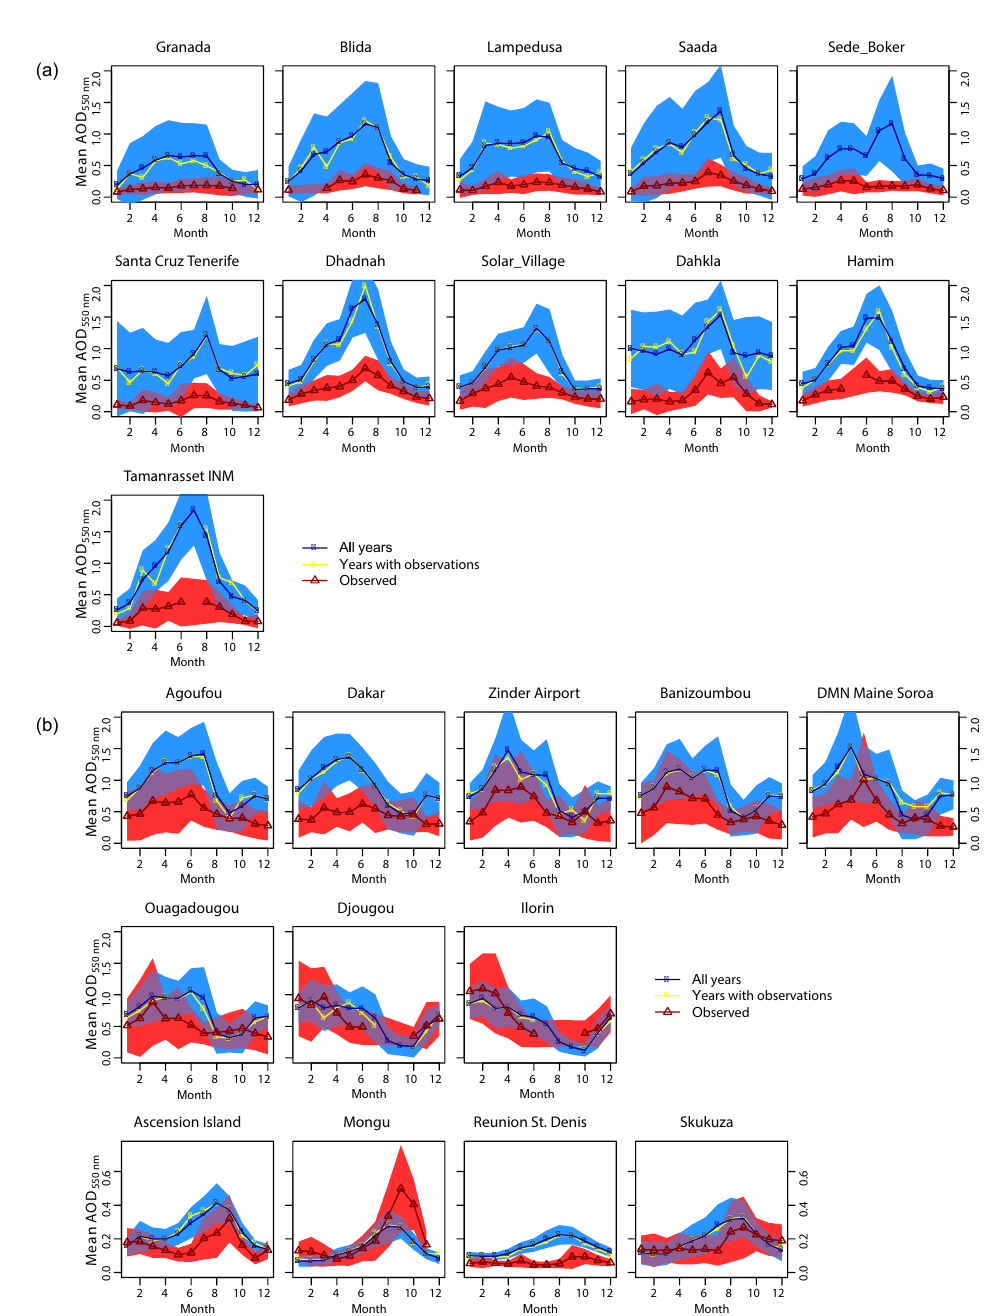
Figure 6. Multiyear mean seasonal cycle of AOD 550nm for observed (red) and modeled with all CCAM outputs, 1999–2012 (blue), and only those months with AERONET data meeting the 70% completeness cutoff (yellow). The ± 1 standard deviation for the observations and CCAM 1999–2012 output across daily means within a given month is